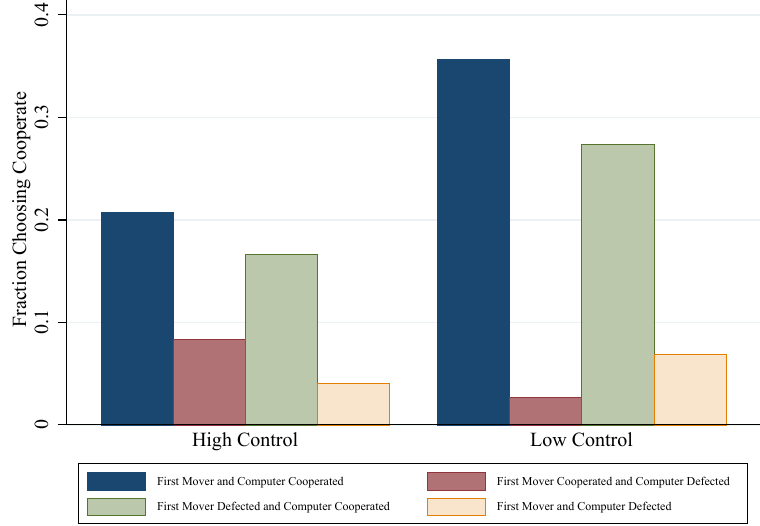
Figure 4. Average Second Mover Cooperation in Known Treatment (First 10